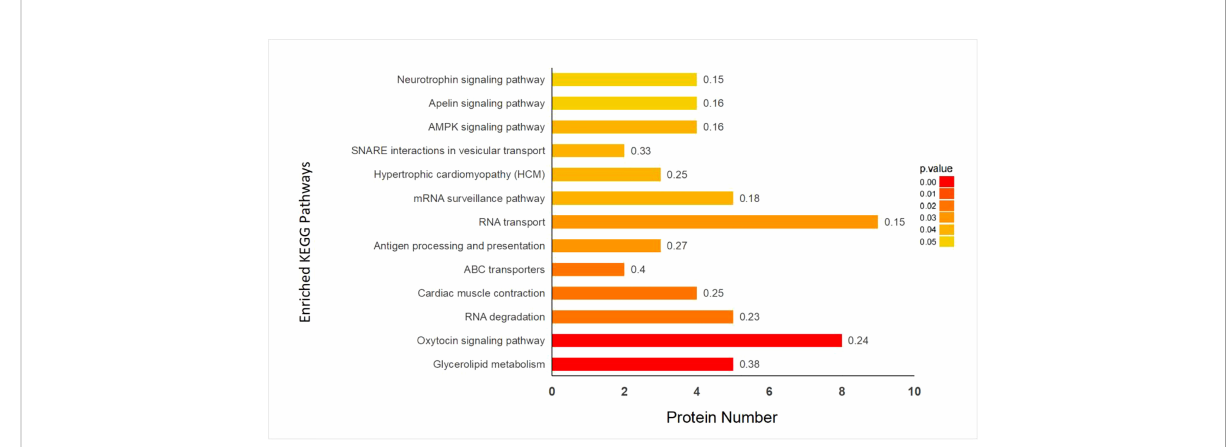
FIGURE 3 Enrichment analysis of KEGG pathway in control (C) and SMC-treated (T) group. The color bar displayed the corrected p -value, which was determined using the Fisher ’ s exact test and Benjamini-Hochberg adjustment. Rich Factor that means the ratio of the DEPs number and the number of all annotated genes in this KEGG pathway was labeled on the top of bar